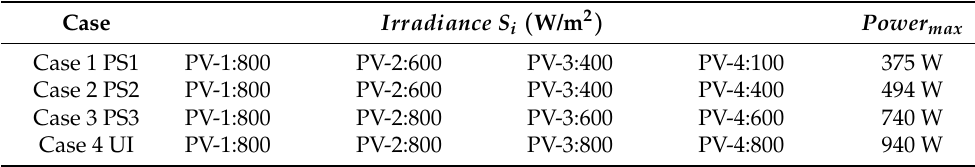
Table 2. P-V and I-V characteristic curves at different irradiance values centralized PV system.